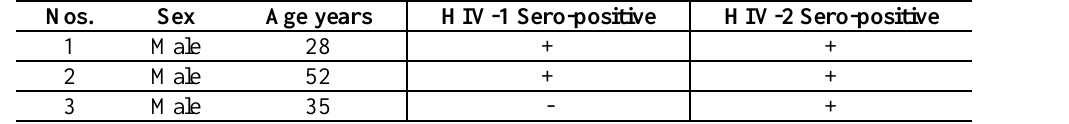
Table I : Details of HIV-2 sero-positive